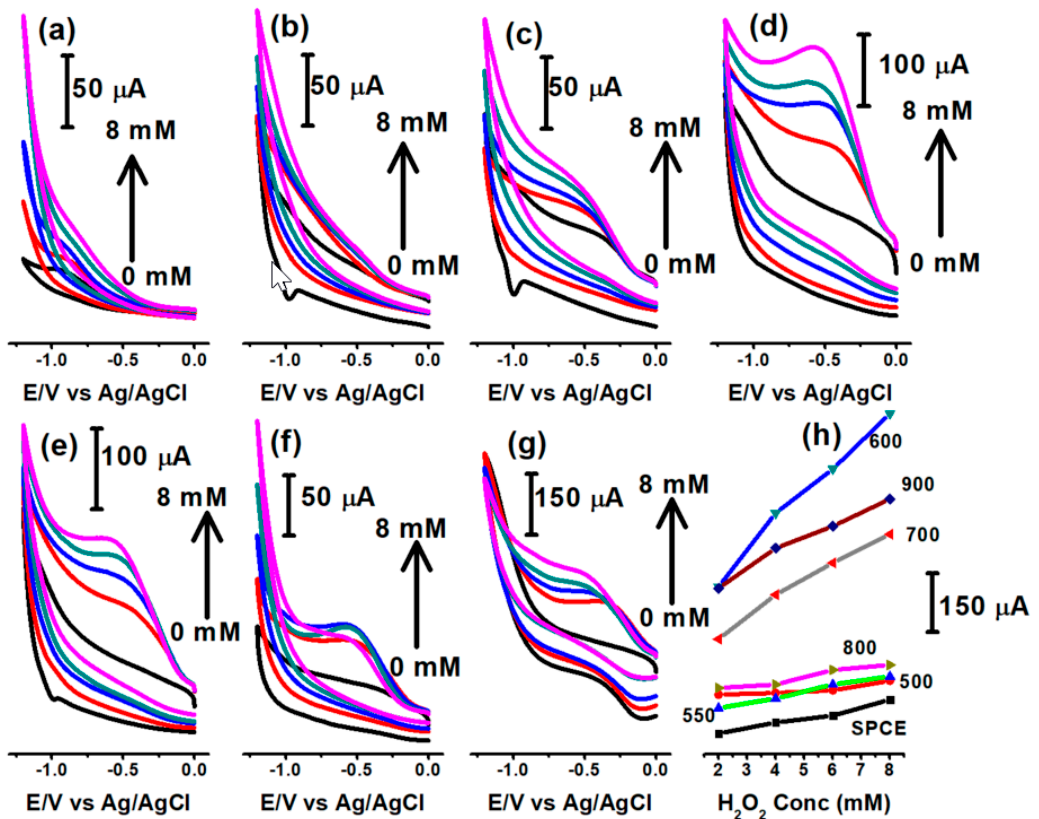
Figure 6. Cyclic voltammetric detection of H 2 O 2 in 0.1 M, pH 7PB ( a ) SPCE, ( b ) SPCE/NPC 500 , ( c ), SPCE/NPC 550 , ( d ) SPCE/NPC 600 , ( e ) SPCE/NPC 700 , ( f ) SPCE/NPC 800 and ( g ) SPCE/NPC 900 , respectively. ( h ) Their corresponding current verses concentration plots.